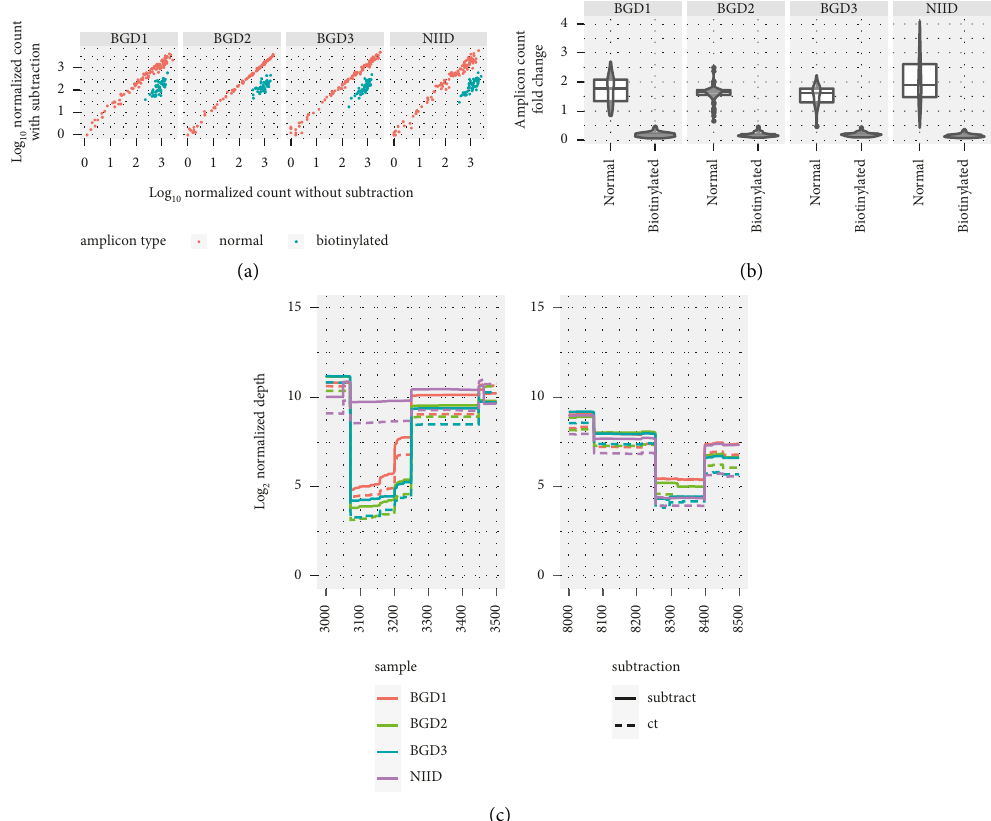
Figure 3: Subtraction of biotinylated amplicons successfully reduced the number of biotinylated amplicons. (a) The NIID, BGD1, 2, and 3 were resequenced with or without biotinylated amplicon subtraction. The read counts for each amplicon region were normalized from 100,000 mapped reads and were log10-transformed. Amplicons with biotinylated primers (blue: biotinylated) and without biotinylated primers (red: normal) are shown for each sample. (b) Fold changes of normalized amplicon counts for each amplicon from the control and subtracted experiments are shown. Distributions of the fold changes are shown in the violin plots, and the 1st quantile, median, and 3 rd quantile values are shown in the box plots. Amplicons with biotinylated primers (biotinylated) and without biotinylated primers (normal) are shown for each sample. (c) Normalized read depths for each sample with or without subtraction are shown. The regions with low depth, genome positions 3000–3500bp (left panel) and 8000–8500bp (right panel) are also shown. Solid lines: depths for the experiments with subtraction (subtract). Dashed lines: depths for the experiments without subtraction